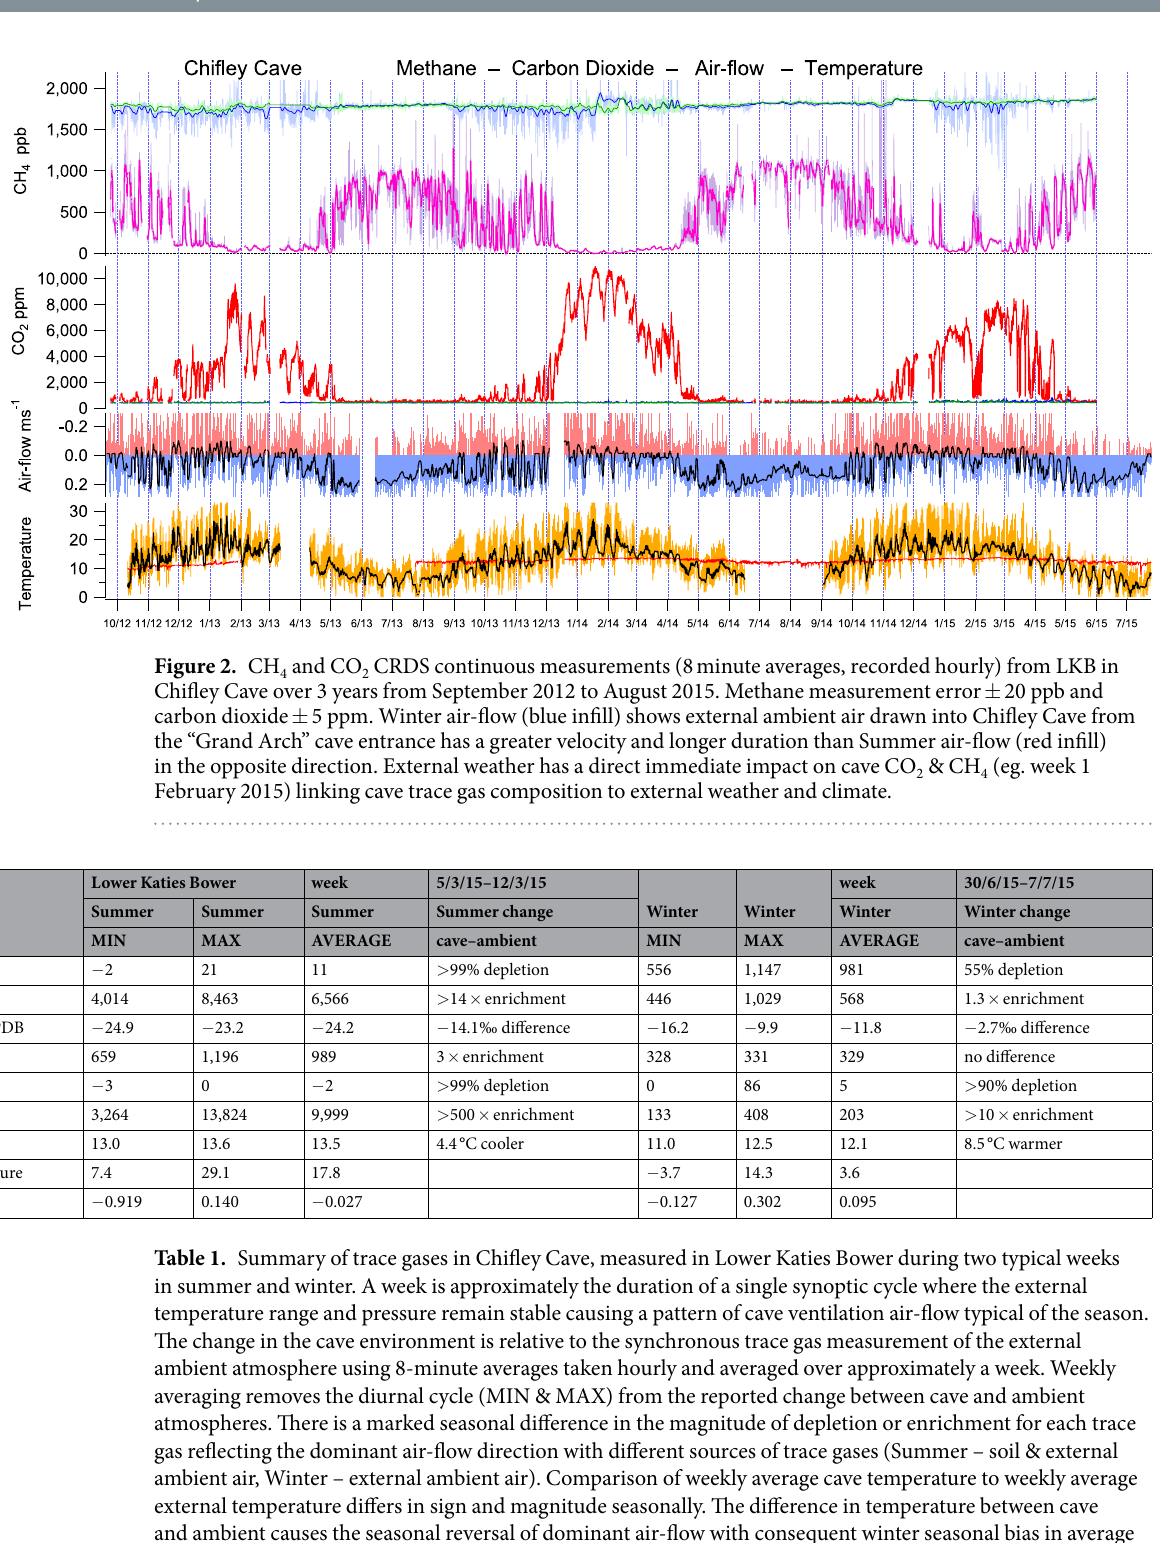
Radon may emanate directly from limestone and cave sediments or be transported from overlying karst soil to the cave environment. Low uranium concentration in limestone and a short effective Rn diffusion path length favour a cave sediment (clay) or karst soil Rn source by a factor of ~100 over a limestone source 12 . This Rn source ratio was tested in Chifley Cave by experiments in which chambers were placed over cave surfaces and the